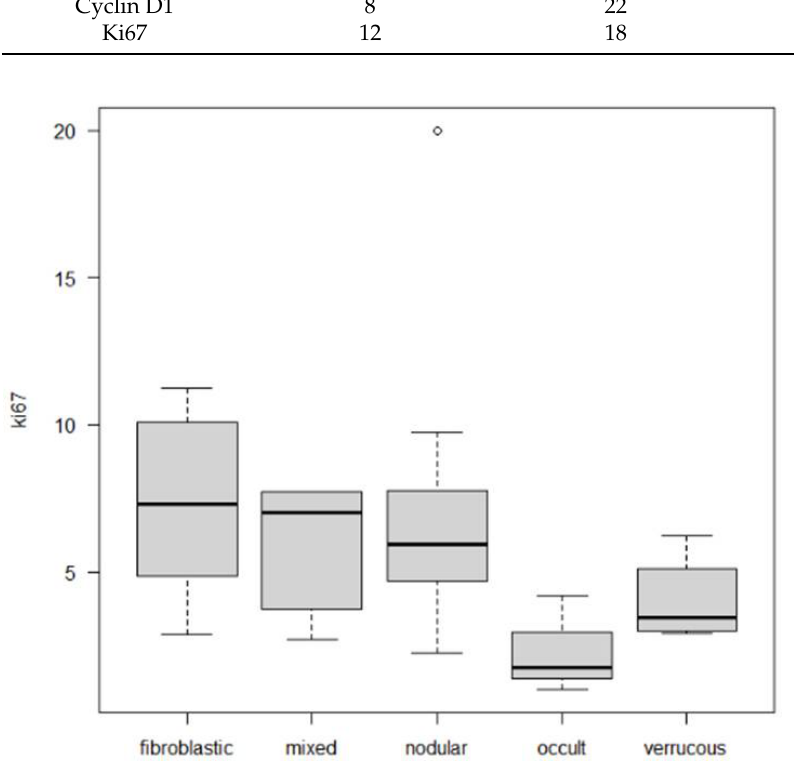
Figure 3. Distribution of Ki67 index in sarcoid clinical subtypes. The fibroblastic, mixed, and nodular subtypes have significantly higher proliferation indexes compared to the occult and verrucous types. (One-way ANOVA, p = 0.021).